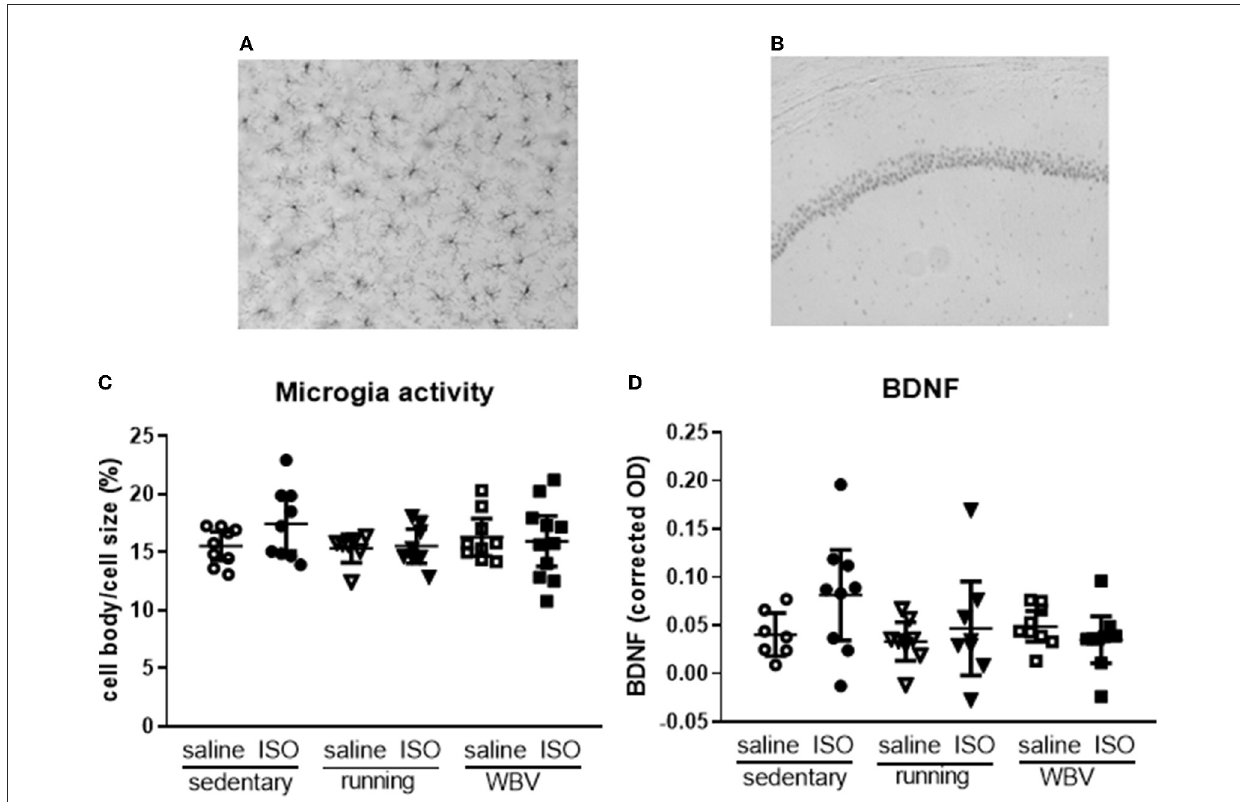
FIGURE5 Typical pictures of IBA-1— (A) (200 × magnification) and BDNF staining (B) (50 × magnification) from the CA1 region of the hippocampus. Mean hippocampal microglia activity (C) and BDNF expression (D) in saline- or isoproterenol (ISO)-treated rats, under sedentary conditions ( n = 8 and n = 9, respectively), or after 5 weeks of exercise training (running; n = 6–8 and n = 8, respectively) or whole-body vibration (vibration; n = 8–9 and n = 9,